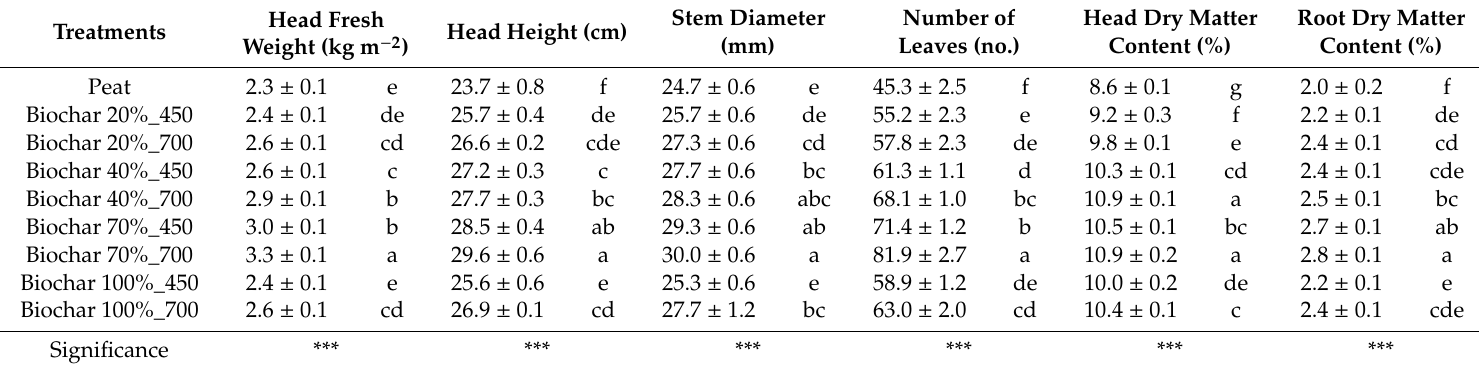
Table 3. ANOVA analysis and means comparisons for head fresh weight, head height, stem diameter, number of leaves, head dry matter content and root dry matter content of curly endive cultivated on di ff erent growing substrates in a protected